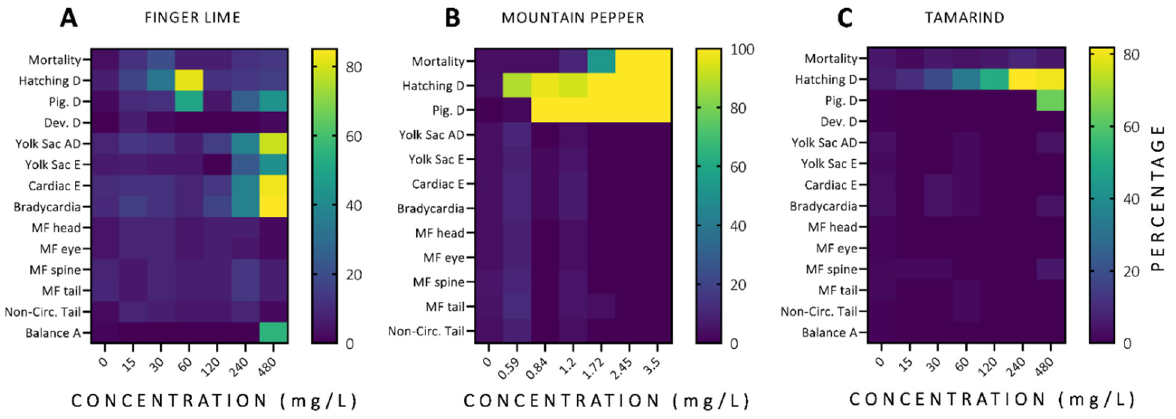
Figure 2. Heatmap of the alterations observed in zebrafish embryos exposed during 96 h to the plant extracts. The mean of three replicates ( n = 20/replicate) is reported for finger lime ( A ), mountain pepper ( B ), and tamarind ( C ).